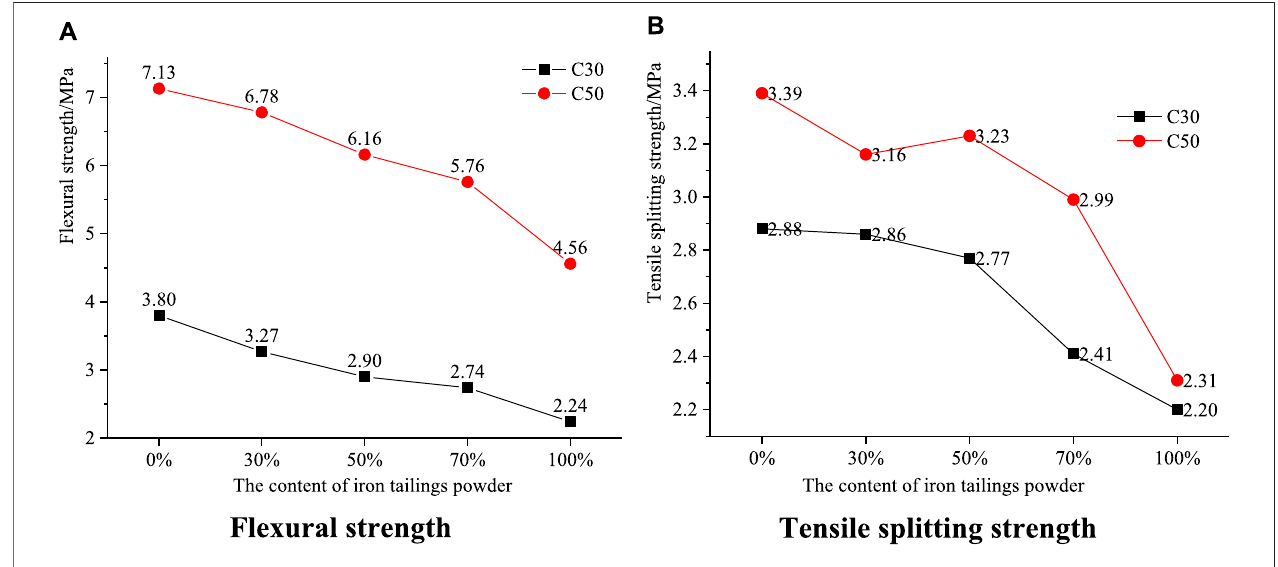
FIGURE 2 | Flexural strength and splitting tensile strength of